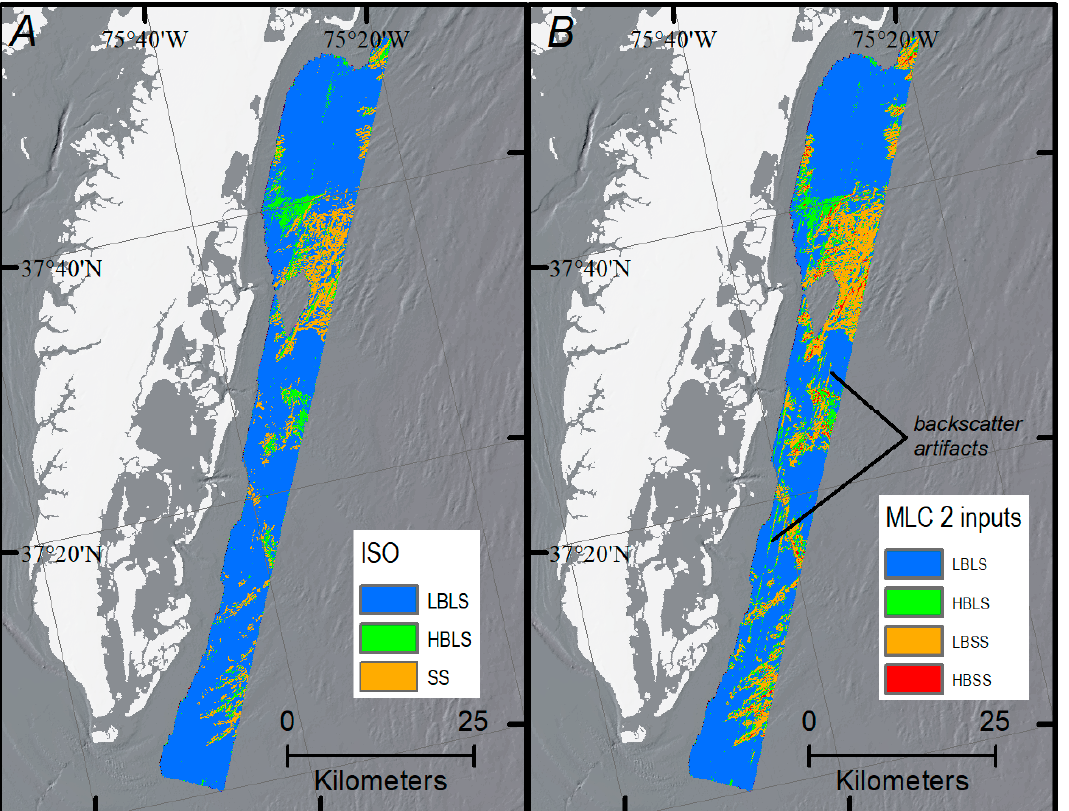
Figure 6. ( A ) ISO classification on the test area, using slope and backscatter intensity. ( B ) MLC on the test area using slope and backscatter intensity.